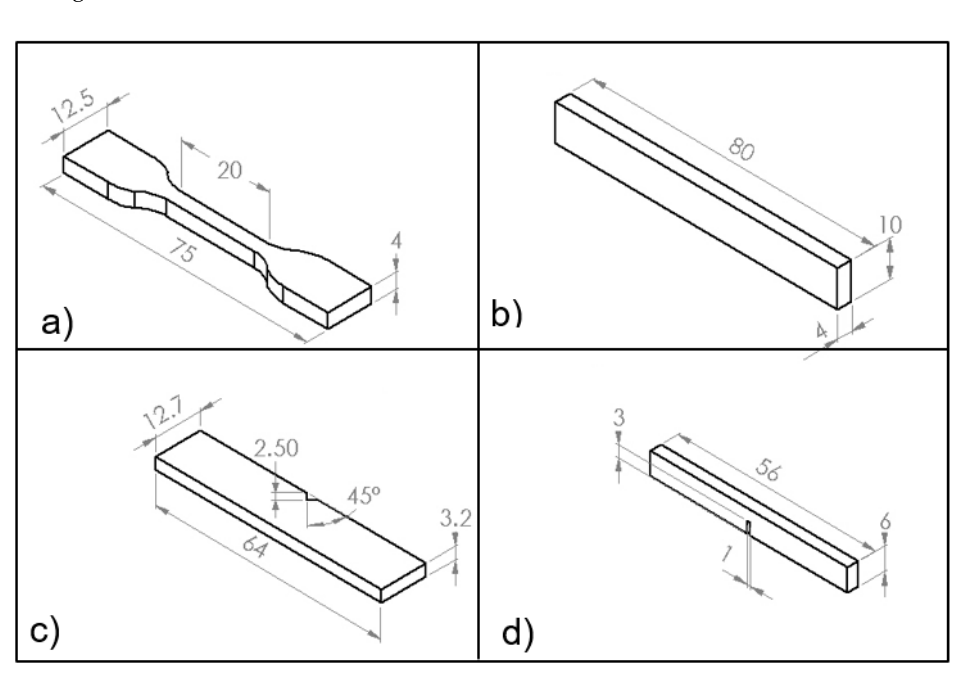
Figure 3. Schematics of samples: ( a ) tensile; ( b ) flexural; ( c ) impact toughness; and ( d ) fracture toughness (All dimensions in mm).